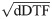
Comparison of effective coupling patterns in APP/PS1 and WT groups.The wiring diagram of effective connections between cortical areas and hippocampus (CA1) expressed in the slow gamma (A) and SWRs (B) frequency band is shown. Continuous coupling exceeding 35% of a maximal value of dDTF in a given group and a given frequency band are indicated by blue arrows. In the APP/PS1 group connections which significantly increased compared to the WT are indicated by thick blue arrows. A significant increase or decrease of the connectivity strength during the occurrence of SWRs is indicated by red and green arrow, respectively.